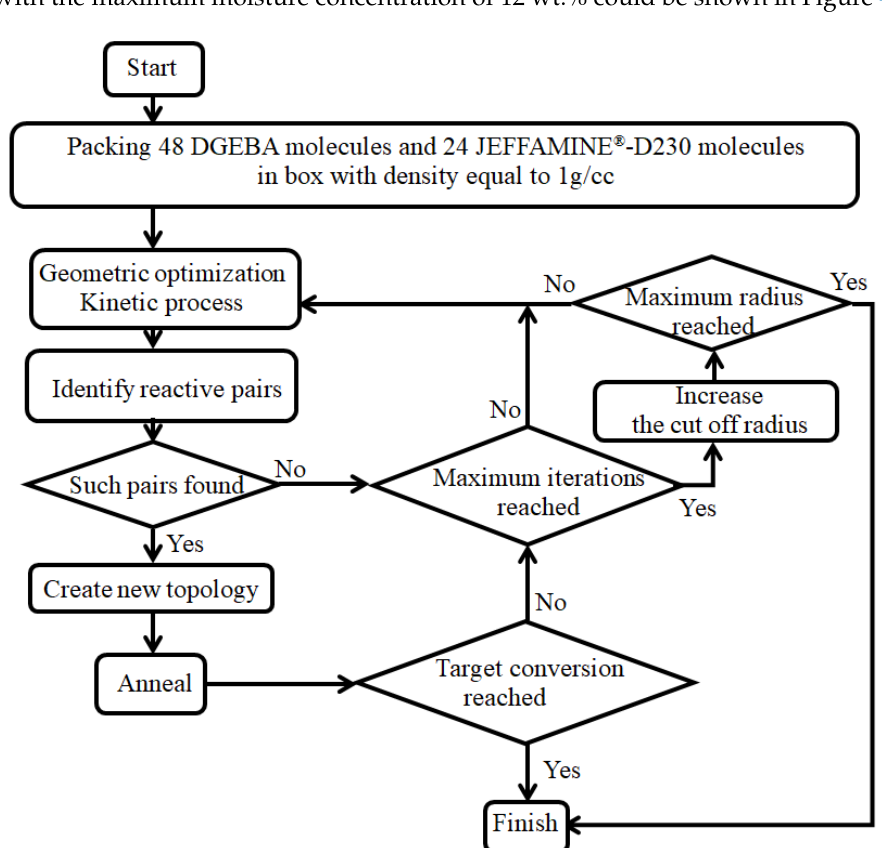
Figure 3. Flowchart of the multi-step cross-linking algorithm.